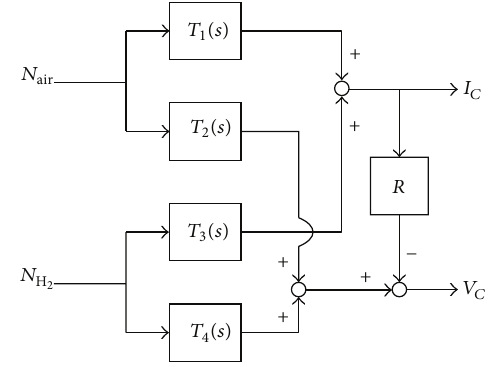
Figure 2: Block diagrams of fuel cell system.